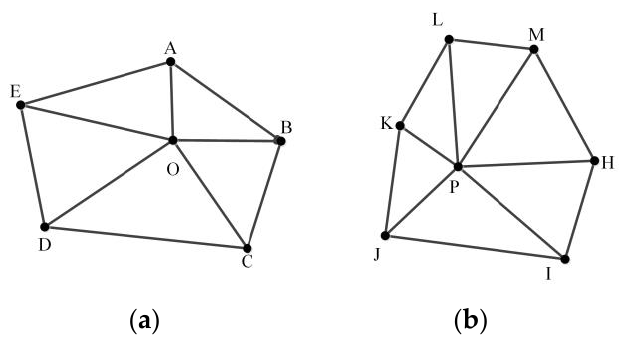
Figure 11. MMU after rotation processing. ( a ) MMU O and (b) MMU P after rotation.